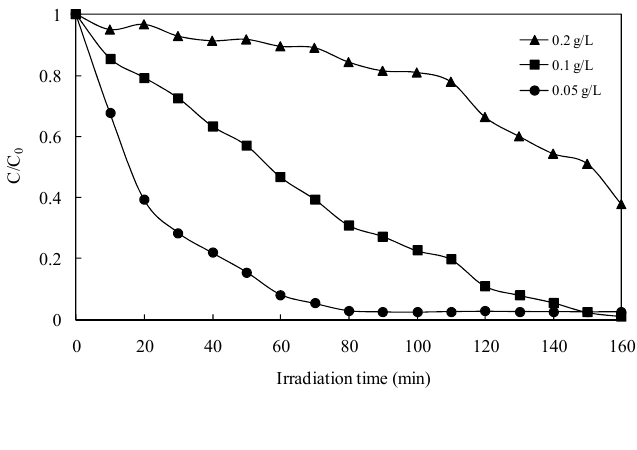
Figure 6. Effect of initial dye concentration on the photocatalytic degradation rate of AO. concentration 1.0 g L − 1 ; pH Experimental conditions: NaBiO 3